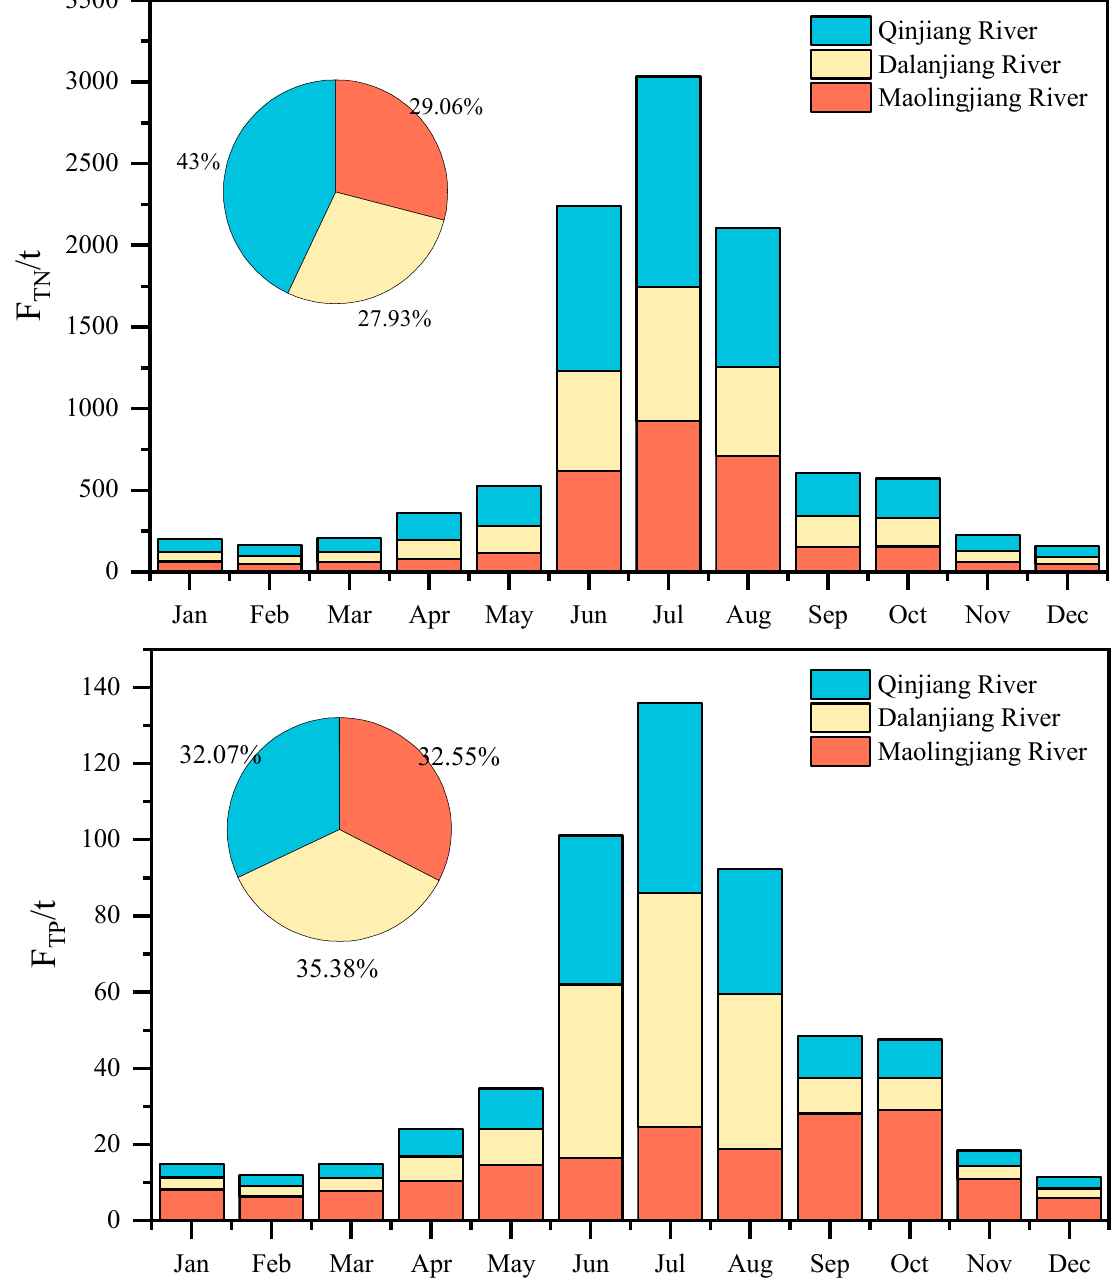
Figure 3. Spatiotemporal flux and contribution patterns of TN and TP in the estuary of the Maowei Sea.